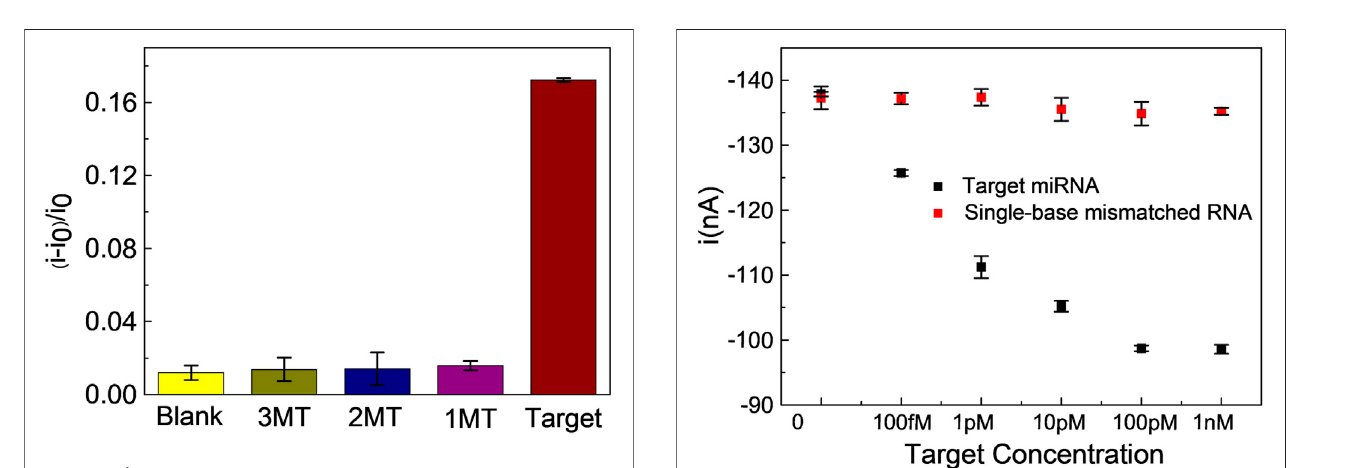
FIGURE 4 | Selectivity of the proposed miRNA biosensor. Reaction mixtures contained 5 μ L λ -Exo (2 U/uL), 5 μ L MB (10 μ M), 5 μ L C-DNA (10 μ M), and 5 μ L miRNA (3MT, 2MT, 1MT and miRNA141). All chemicals were dissolved in 10 mM pH 7.4 Tris-HCl buffer containing 0.1 M KCl. The error bars represented the standard deviation of three repetitive measurements.